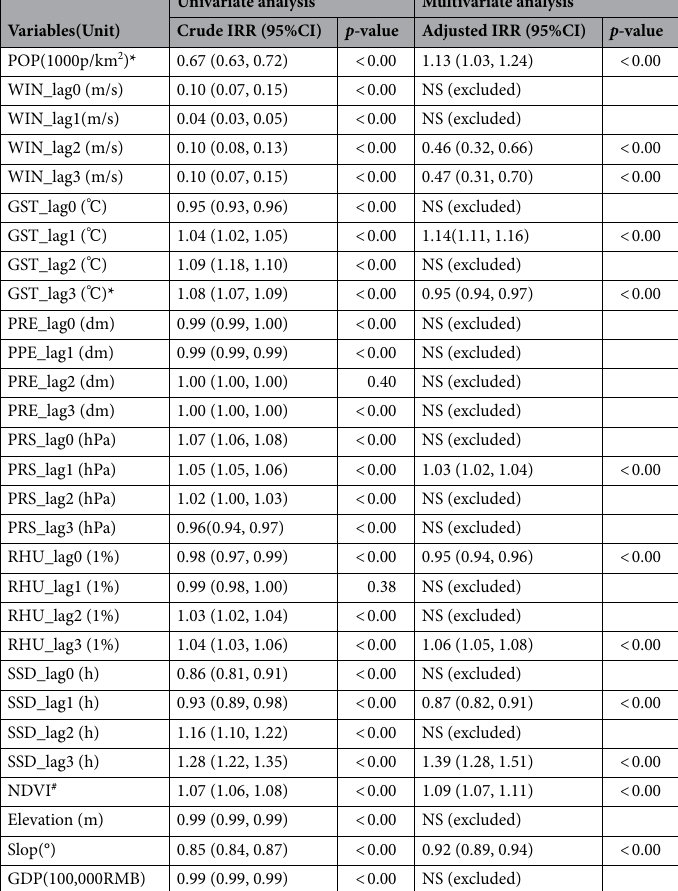
Table 6. The association between monthly scrub typhus cases and potential influencing factors by panel negative binomial regression. *The variables showed opposite correlations in univariate and multivariate analyses. NS: Non-significant variables with p-value greater than 0.01. NDVI # : Its value is equal to NDVI multiplied by 100; POP: Population density. Factor_lag(k): factor with k-month lag, for example, EVP_lag1 represents EVP with 1-month